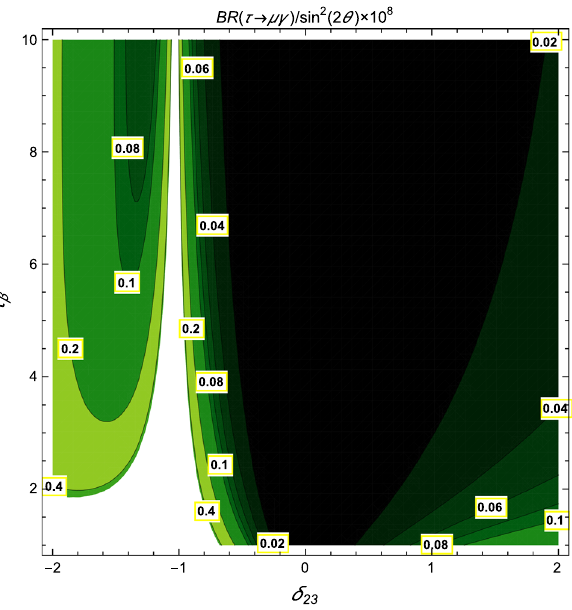
Fig. 4 Contours of the SLHM contribution to the τ → μγ branching ratio in the δ 23 vs. t β plane. We set z 2 = 1 and f = 2000